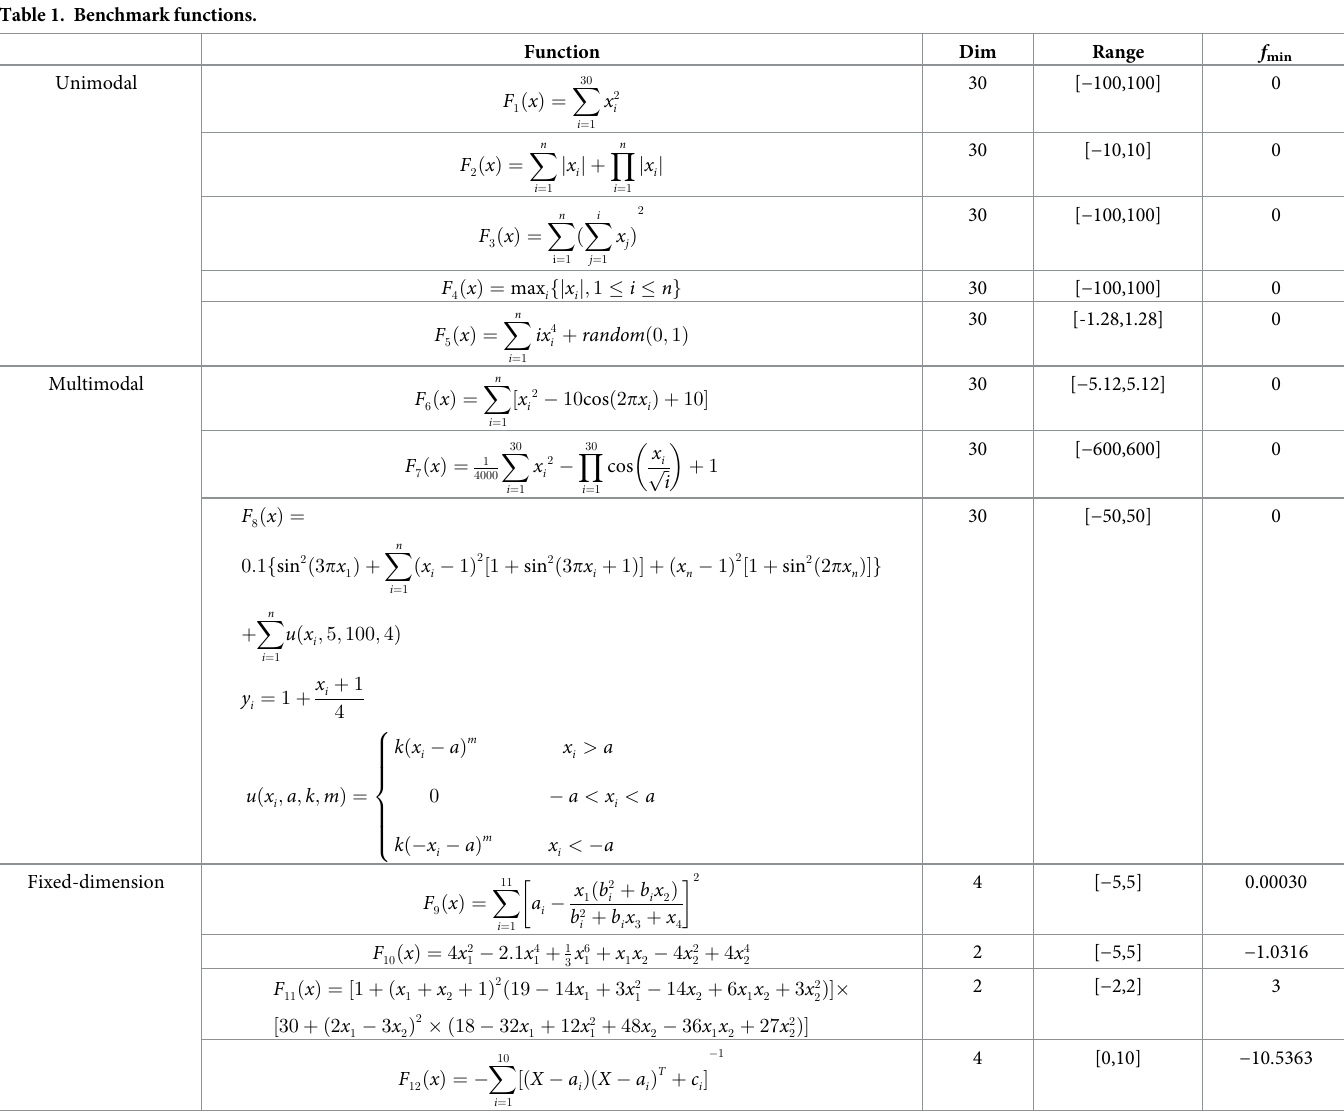
Table 1. Benchmark functions.